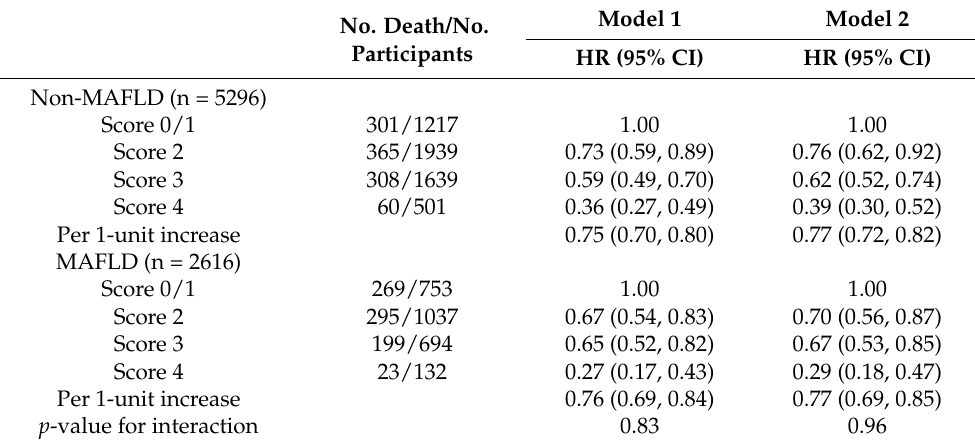
Table 2. Associations between healthy lifestyle and all-cause mortality in participants with and without